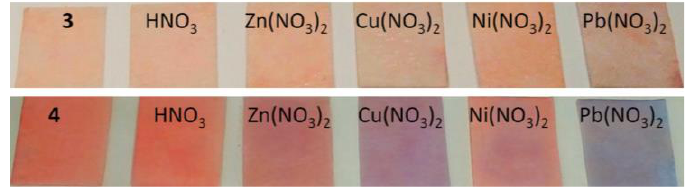
Figure 10. Changes of the color of test strips (glass filter) with adsorbed crowns 3 (2.9 × 10 − 4 M) and 4 (3.1 × 10 − 4 M) after immersing them for 15 s in solutions of (from left): deionized water, nitric acid (10 − 1 M) and metal nitrates (10 − 2 M) at pH 5.